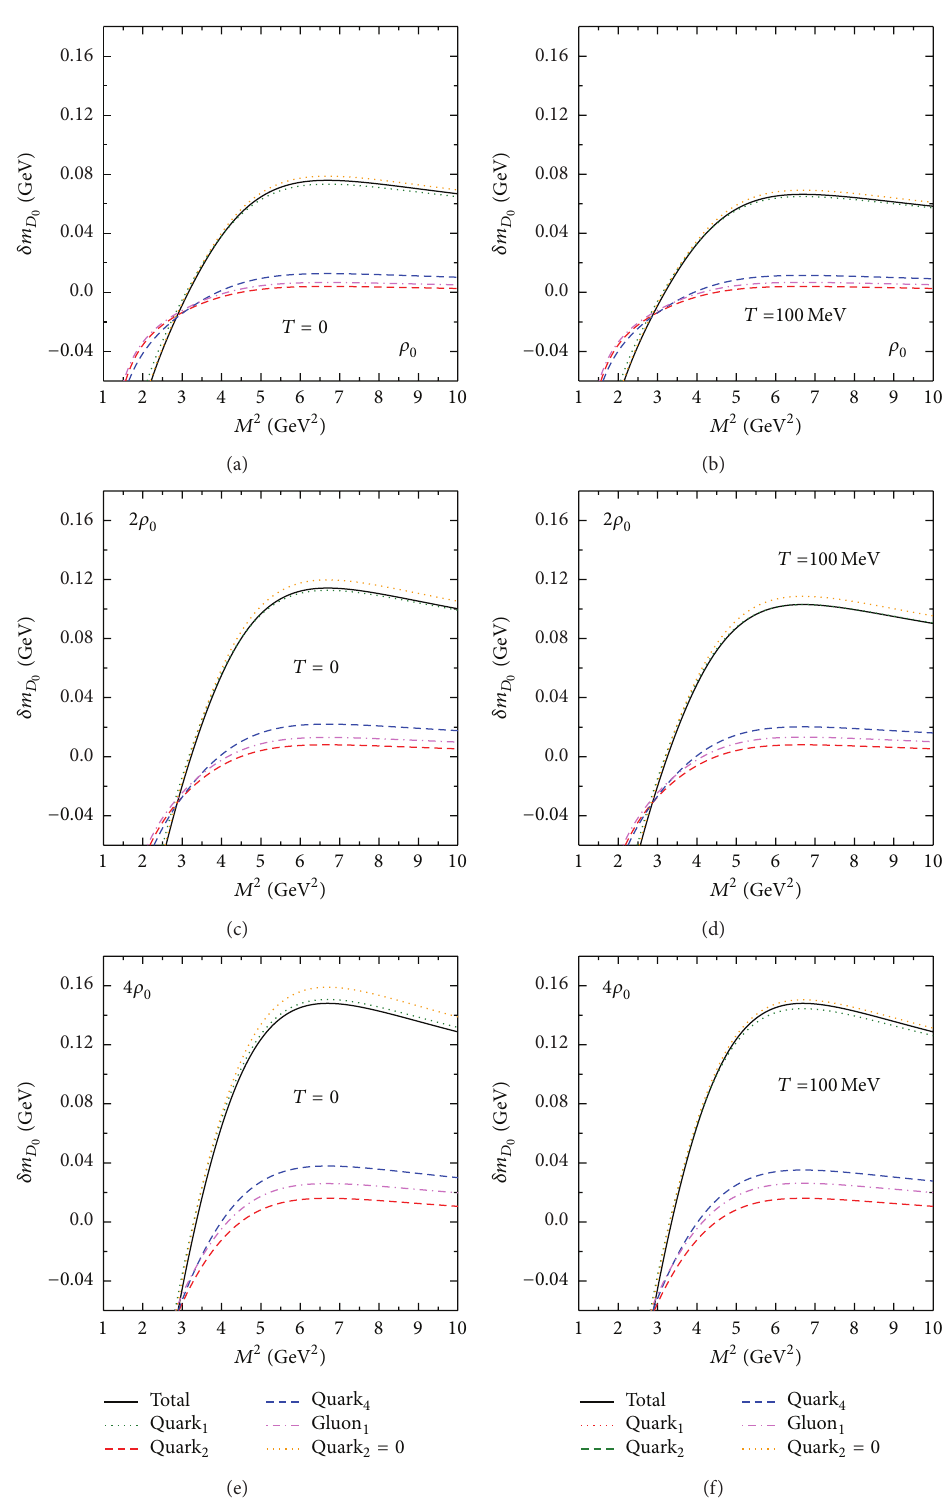
Figure 6: (Color online) Figure shows the contribution of individual condensates to the mass shift of scalar mesons 𝐷 0 as a function of the squared Borel mass parameter, 𝑀 2 . The subplots (a), (c), and (e) show the results at temperature 𝑇 = 0, whereas the subplots (b), (d), and (f) are plotted for temperature 𝑇 = 100MeV. We have shown the results at baryon densities 𝜌 0 , 2𝜌 0 , and 4𝜌 0